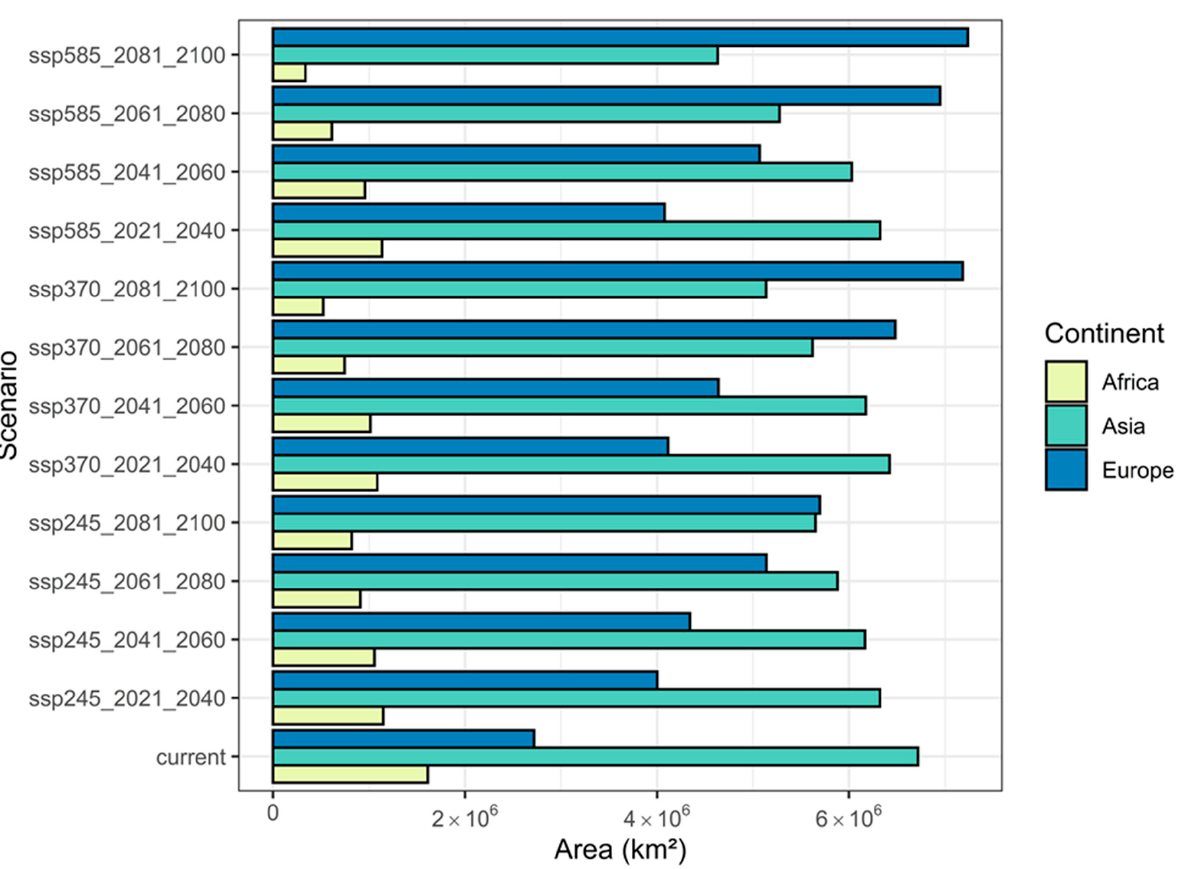
Figure 4. Change in total area suitable for the species by continent.